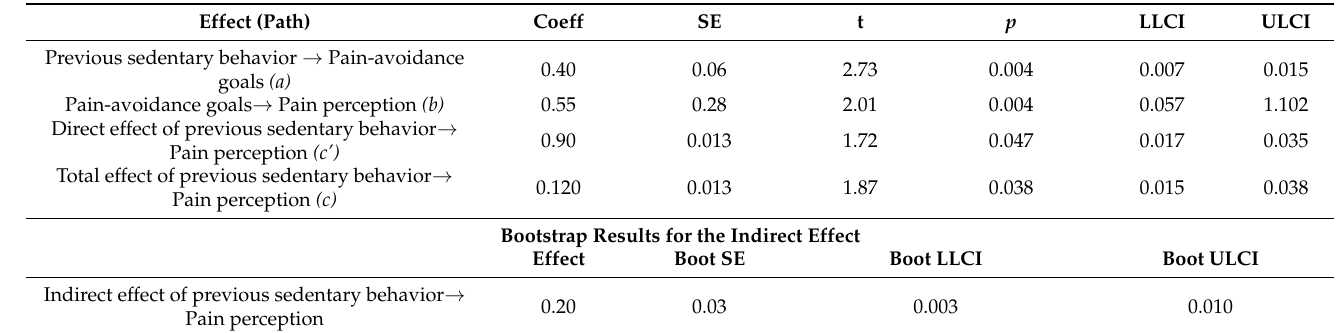
Table 2. The mediation model showing the effect of previous sedentary behavior on pain after the 6MWT via a preference for pain-avoidance